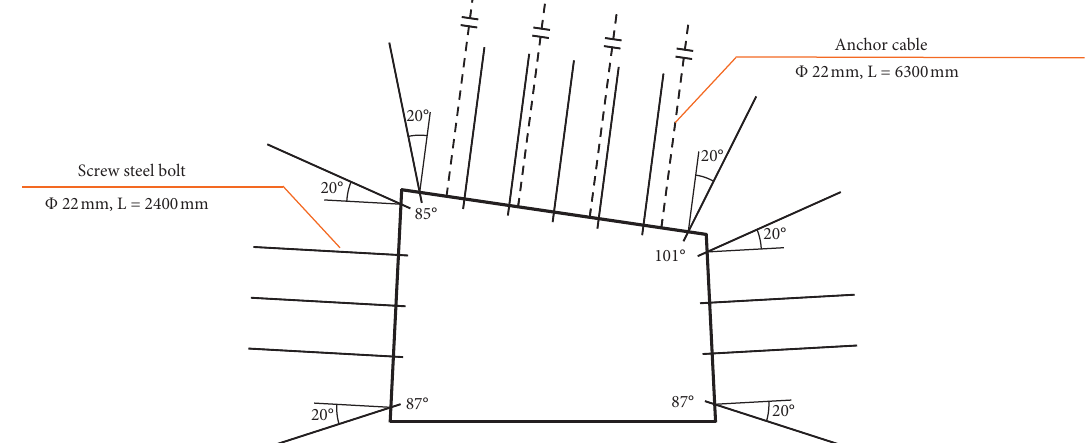
Figure 9: Schematic diagram of the roadway support.